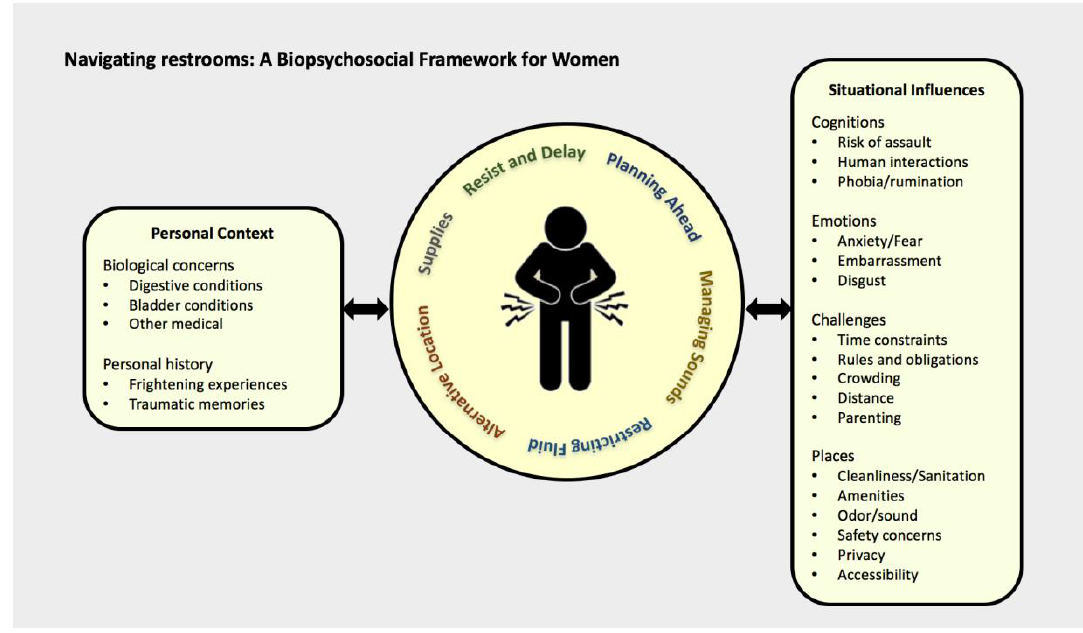
Figure 1. A biopsychosocial framework for women navigating restrooms.